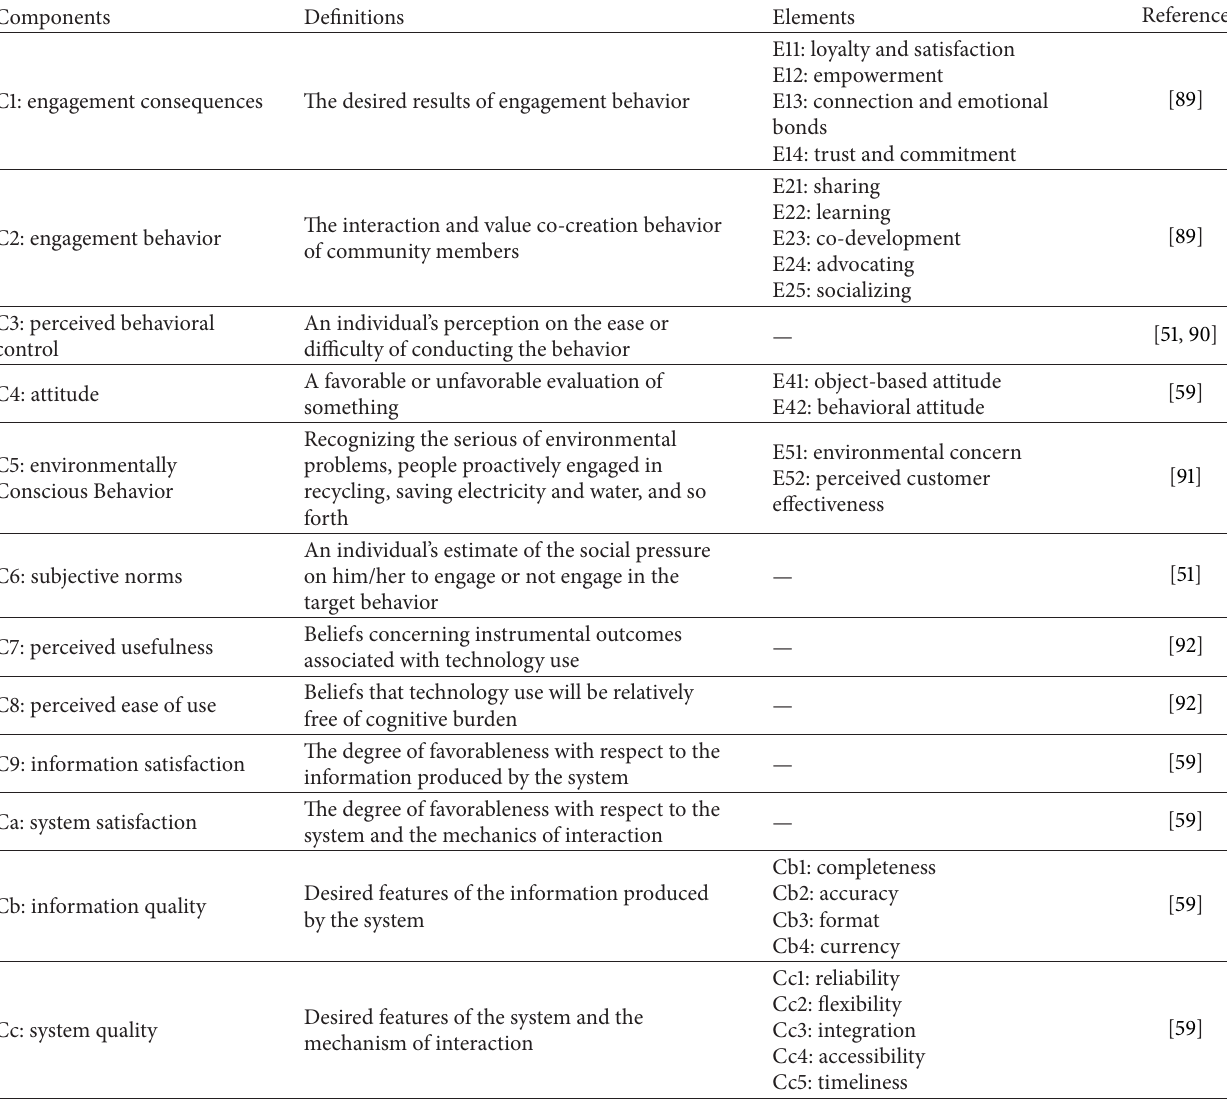
Table 1: System component